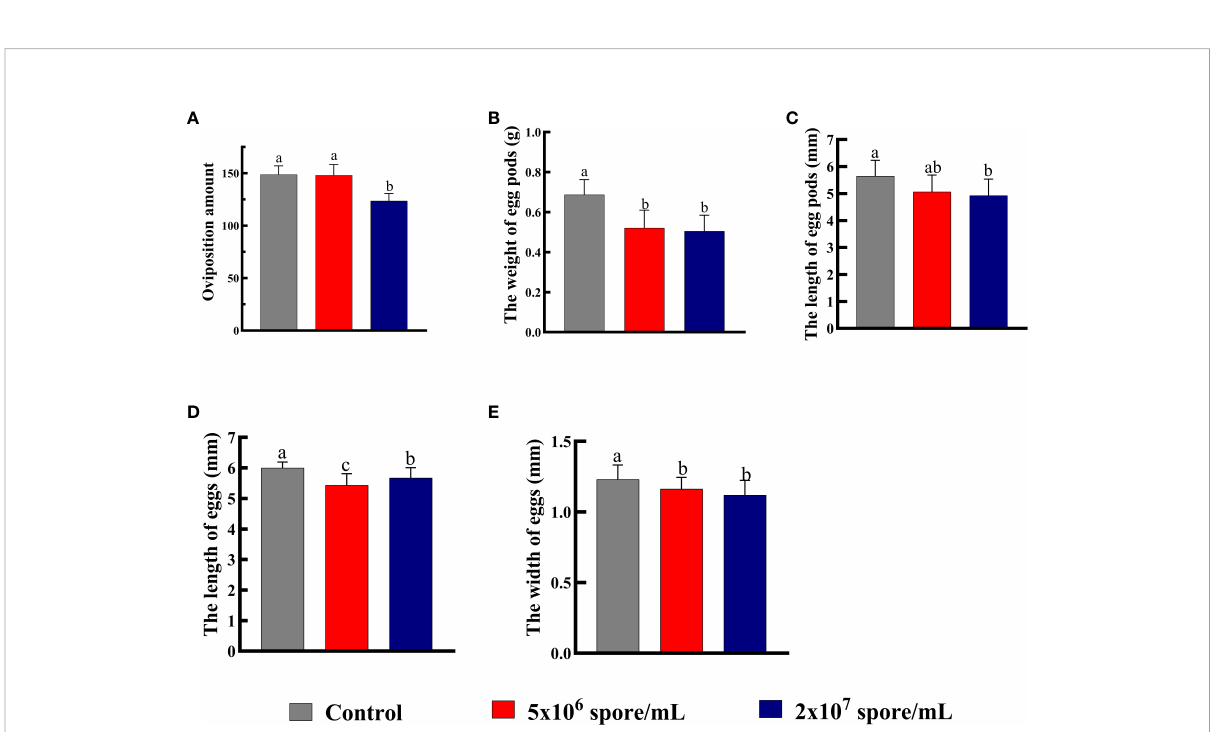
FIGURE 5 Number and quality of eggs laid by L. migratoria manilensis infected with P. locustae. (A) Oviposition amount or total number of eggs laid by a single adult female. (B) Average weight of egg pods laid by a single adult female. (C) Average length of egg pods laid by a single adult female. (D) Average length of eggs laid by a single adult female. (E) Average width of eggs laid by a single adult female. Each value is presented as mean ± SD, and the different letters indicate signi fi cant differences among different treatments (one-way ANOVA followed by Tukey ’ s multiple comparisons test, P <